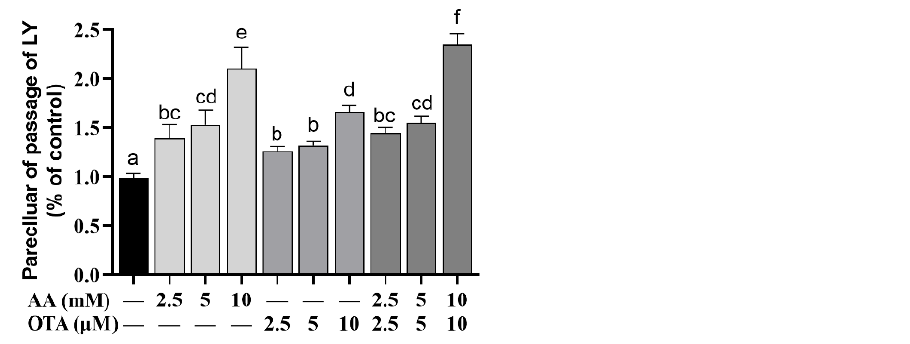
Figure 4. Effect of AA and OTA on the permeability of LY. a – f Different letters indicate significant differences, p < 0.05.